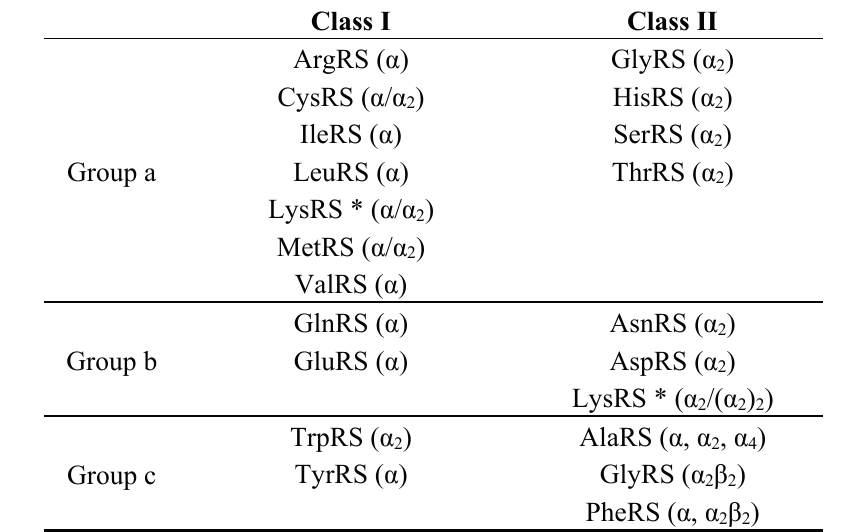
Table 1. Table of AARSs by class. LysRS (denoted with a *) can exist as either a class I or class II AARS. AARSs can exist as a monomers ( α ), homodimers ( α 2 ), or homo- or hetero-tetramers (( α 2 ) 2 / α 4 or α 2 β 2